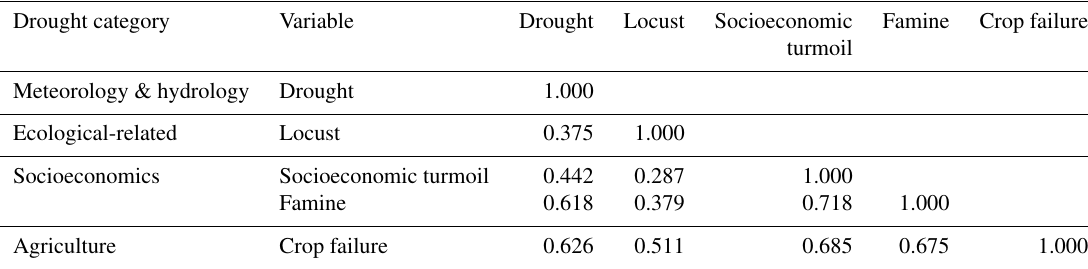
Figure 5. The 9-year running variance for the multiple variables of REACHES. Table 2. Correlation coefficients of REACHES multiple